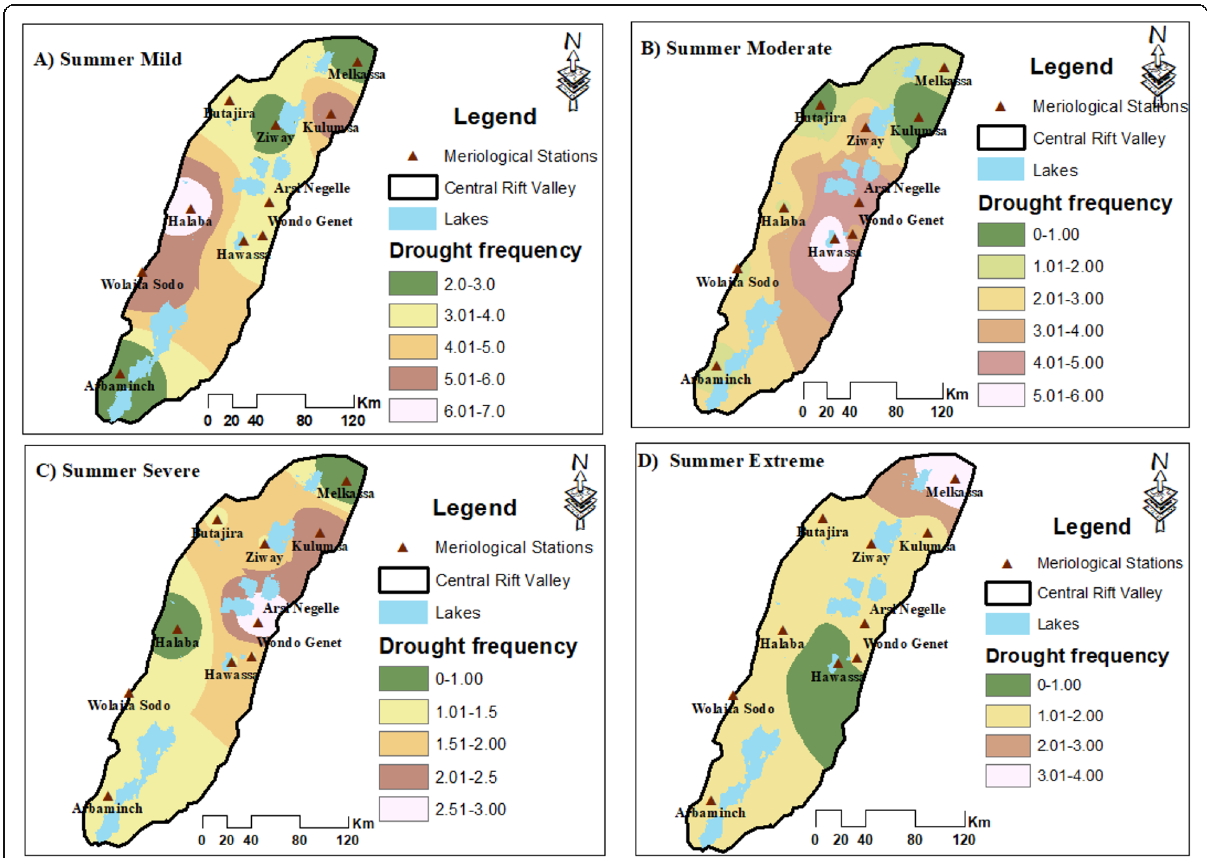
Fig. 8 Spatial patterns of drought events in summer season in LRERV of Ethiopia: a mild drought, b moderate drought, c severe drought, d extreme